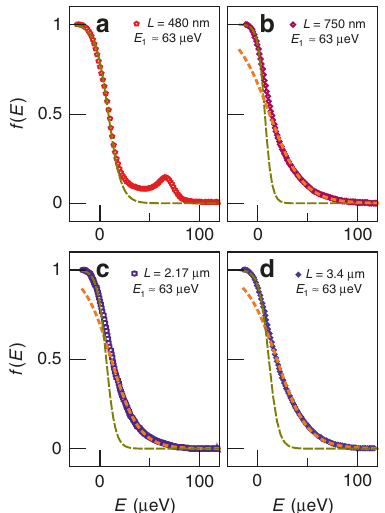
Fig. 6 Length dependence and prethermalization. Measured f ( E ) for an injection energy E 1 ≈ 63 μ eV at a L = 480 nm, b L = 750 nm, c L = 2.17 μ m, and d L = 3.4 μ m. The symbols are experimental data, and the dotted (resp. dashed) lines are Fermi function fi t of the high-energy (resp. low-energy) part of the